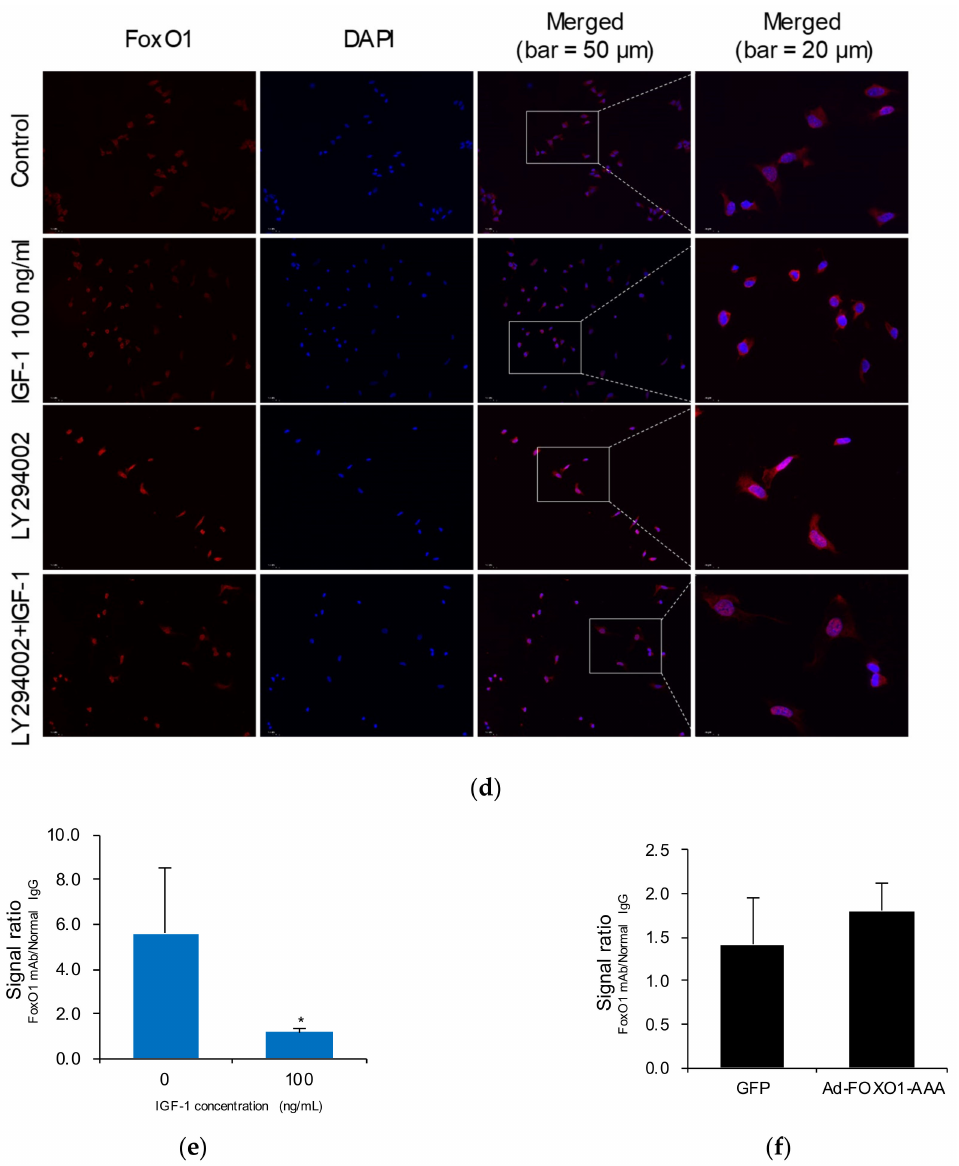
Figure 5. IGF-1 acts in the P13K/AKT pathway to promote SK-N-SH cellular proliferation and inhibit the nuclear translocation of FoxO1. ( a ) SK-N-SH cell viability with or without IGF-1 and P13K inhibitor (LY294002) treatment; ( b ) Edu+ cell percentage as determined by 5-ethynyl-2-deoxyuridine (EdU) staining in cells with or without IGF-1 and P13K inhibitor (LY294002) treatment; ( c ) representa- tive images of EdU staining of cells with or without treatment with 100 ng/mL of IGF-1 and a P13K inhibitor (LY294002). The nuclei were stained blue; the nuclei of cells possessing high levels of DNA replication (EdU+ cells) were simultaneously stained green. Scale bar: 20 µ m; ( d ) representative images of FoxO1 staining of cells with or without IGF-1 and P13K inhibitor (LY294002) treatment. Scale bar: 50 or 20 µ m; ( e , f ) chromatin immunoprecipitation assay results of FOXO1 binding to the promoter regions of GPR17 . Data are presented as a signal relative to the FoxO1 (C29H4) Rabbit mAb #2880/Normal Rabbit IgG #2729 input ratio. Normal rabbit IgG #2729 is an internal reference. The ratio is used to determine the binding rate of FOXO1 to the promoter regions of GPR17 . Cells with or without (control) treatment with 100 ng/mL of IGF-1 after starvation for 24 h ( e ); normal cells with or without FOXO1 adenoviral vector treatment (green fluorescent protein, GFP; control) ( f ). Results were obtained from three separate experiments. Data are presented as the mean ± SD. * p < 0.05 vs. control; ** p < 0.01 vs. control; ## p < 0.01 vs. the IGF-1